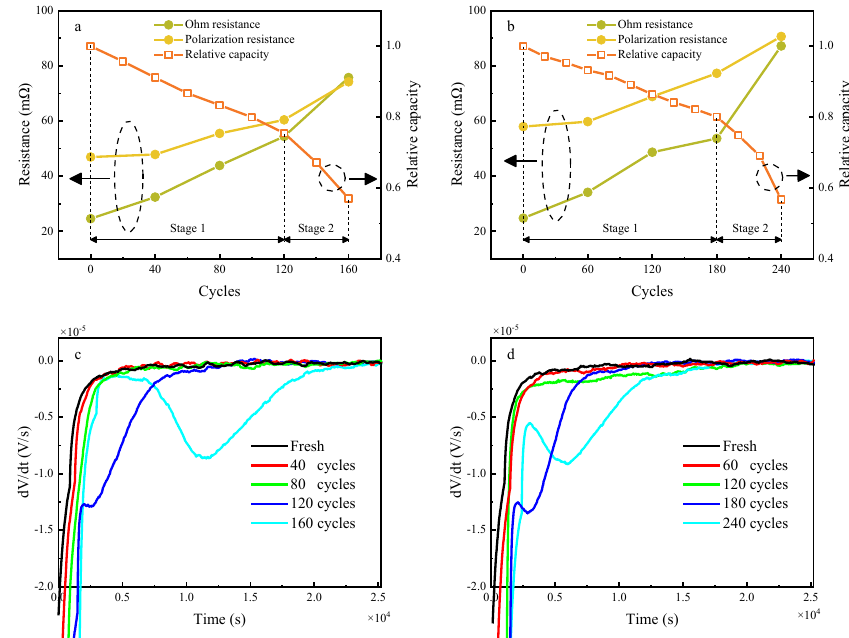
Fig. 2. The relative capacity attenuation curves and the internal resistance increase curves under 50%SOC of battery #1 (a), and battery #3 (b). The voltage relaxation behavior analysis curves at different cycles of battery #1 (c), and battery #3